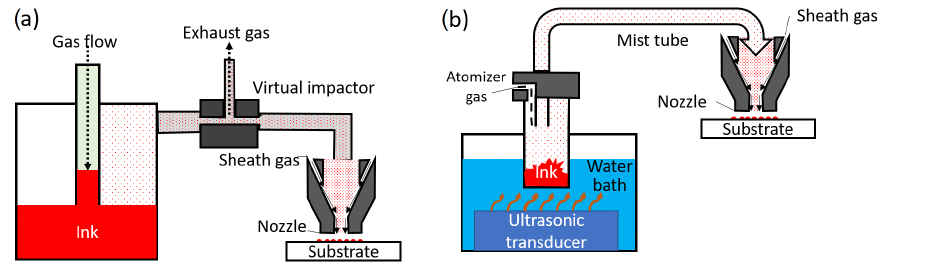
Figure 18. Schematics of ( a ) pneumatic and ( b ) ultrasonic aerosol jet